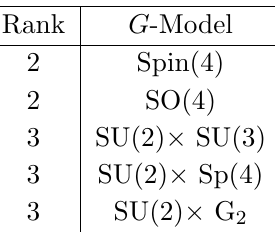
Table 1 . Simplest collisions of singularities. We assume that G is a semi-simple non-simply connected group of rank 2 or 3. The Spin(4) and SO(4)-models are studied in [35]. The G =SU(2) (cid:2) SU(3) is studied in [36], the G =SU(2) (cid:2) Sp(4) is studied in [39], and the G =SU(2) (cid:2) G 2 is the subject of the present